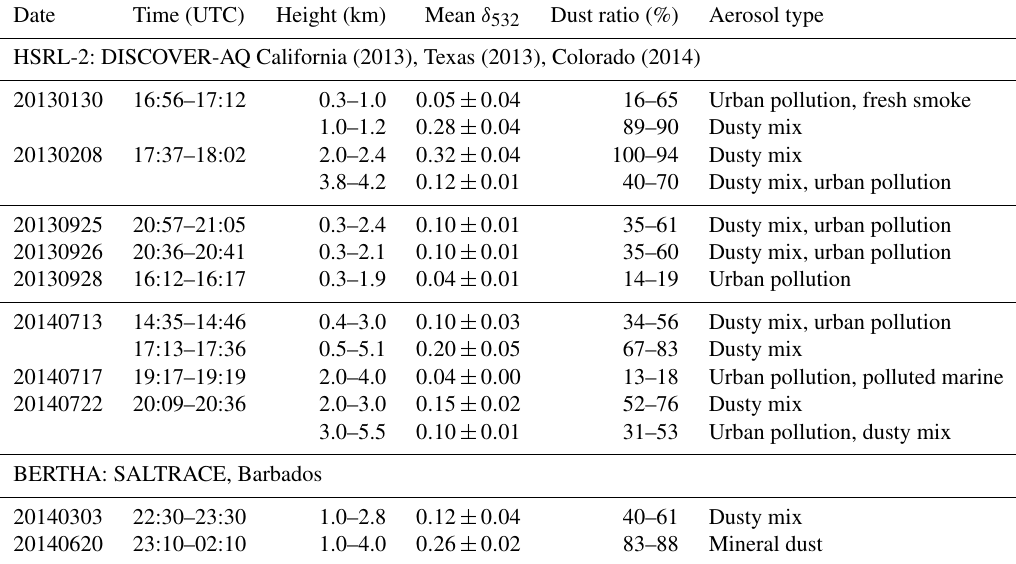
Table 1. Overview of the 3 + 2 + 3 lidar measurements taken with BERTHA and HSRL-2 and used in this study. The HSRL-2 aerosol type was determined following the procedure outlined in Burton et al. (2012). Note that HSRL-2 measurements include transit flights. The lower and upper values for the range of dust ratios refer to values obtained from using methods described by Tesche et al. (2009b) and Mamouri and Ansmann (2014) (sum of fine and coarse dust),